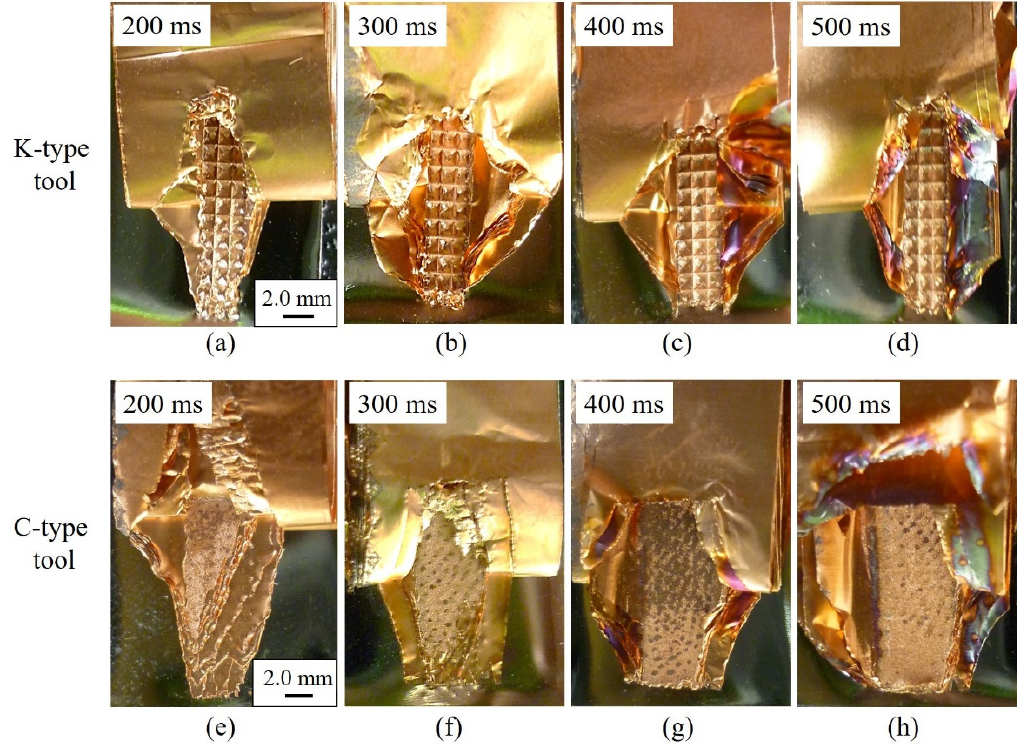
Figure 8. Fracture pattern after tensile shear test. ( a – d ) and ( e – h ) are joints bonded with K-type tool and C-type tool, respectively.